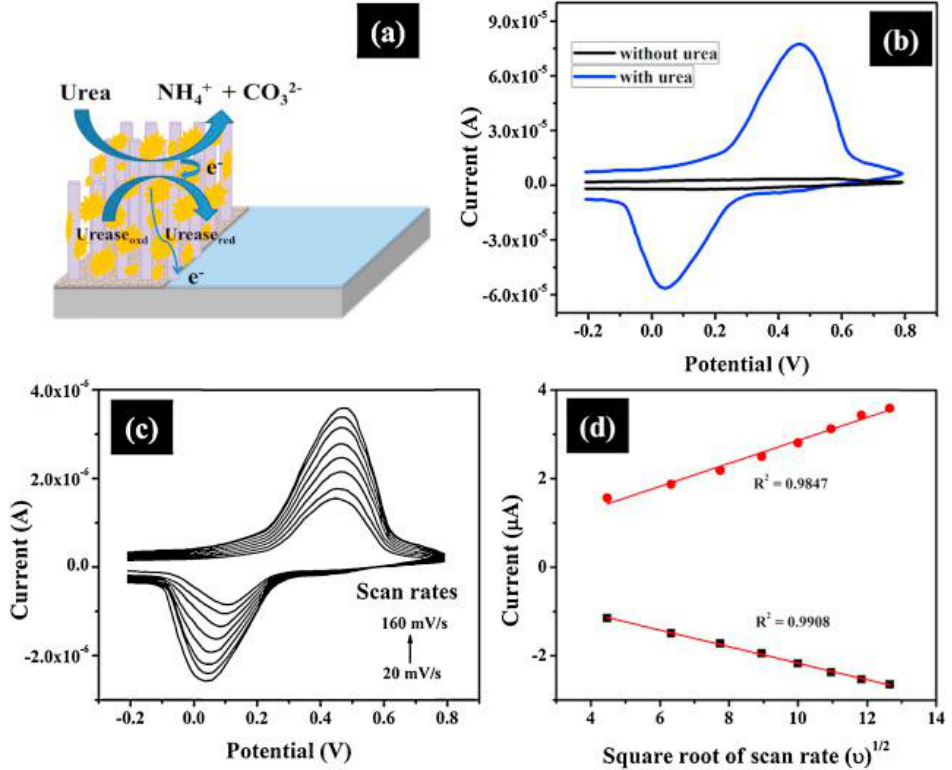
Figure 3. ( a ) Schematic drawing of a prototype sensor (glass/Ag/ZnO NRs/urease) for urea sensing, ( b ) CVs of urea sensor in absence and presence of 0.5 mM urea at 50 mV/s scan rate in PBS (pH 7); ( c ) CVs at different scan rates, 20–160 mV/s, and ( d ) magnitudes of peak oxidation ( I pa ) and reduction ( I pc ) currents as a function of (scan rate) 1/2 . Reprinted from [29].